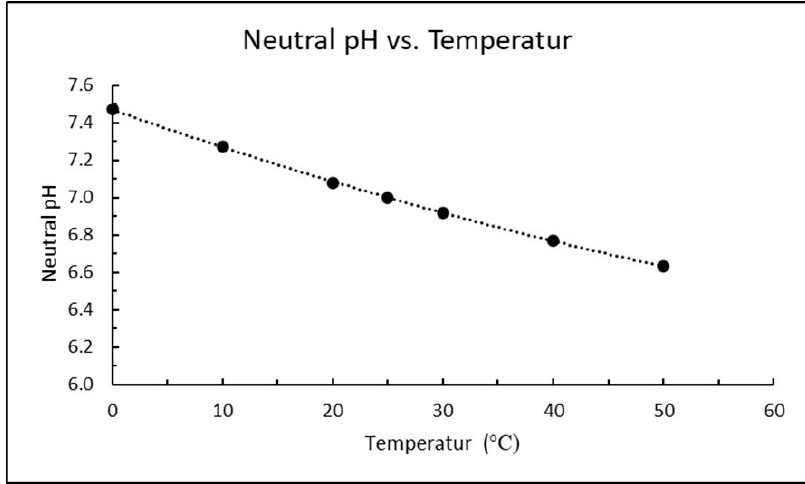
Figure 2. pH for neutral water as a function of temperature (t) in the range 0–50 °C plotted from tabular data [12]. The regression line follows formula neutral pH = 8 × 10 − 5 × t 2 − 0.0208 × t + 7.4692 with regression factor r 2 = 0.9999.